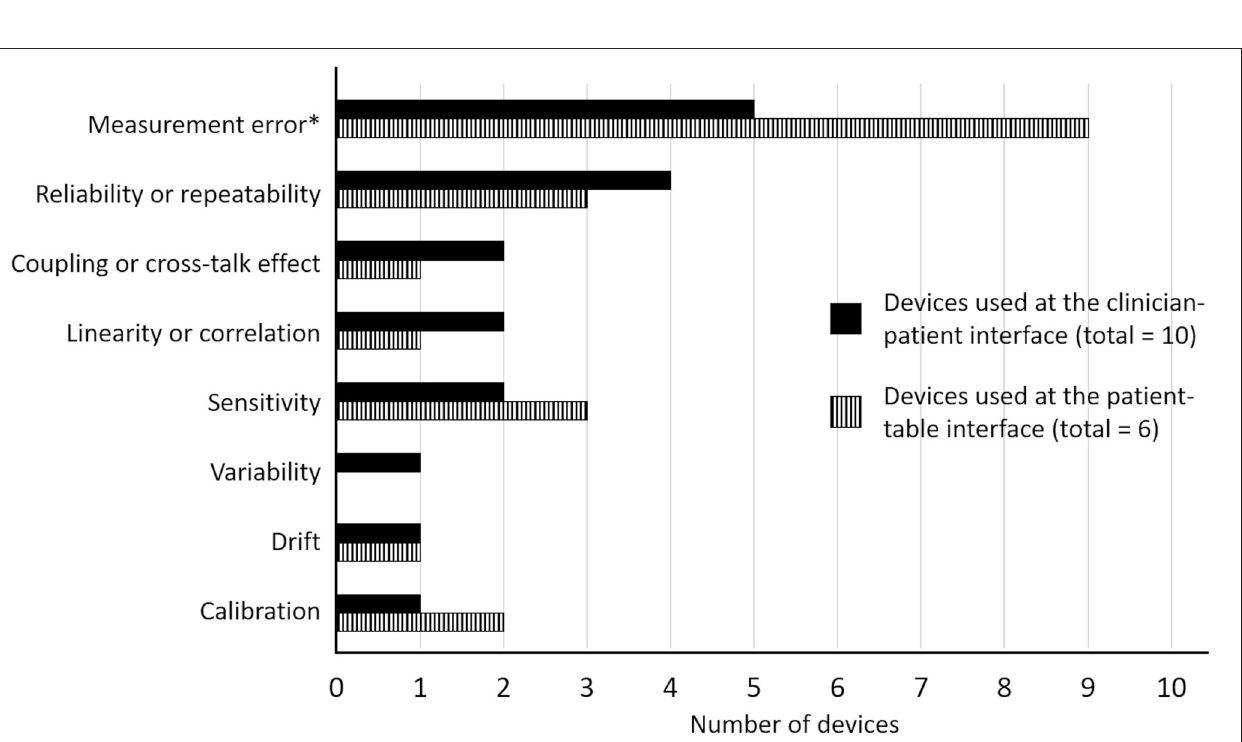
FIGURE 3 | Reporting frequency of the metrologic properties for devices used at the clinician-patient interface and at the patient-table interface. * Measurement error was reported as the device validity, accuracy, fidelity or calibration.